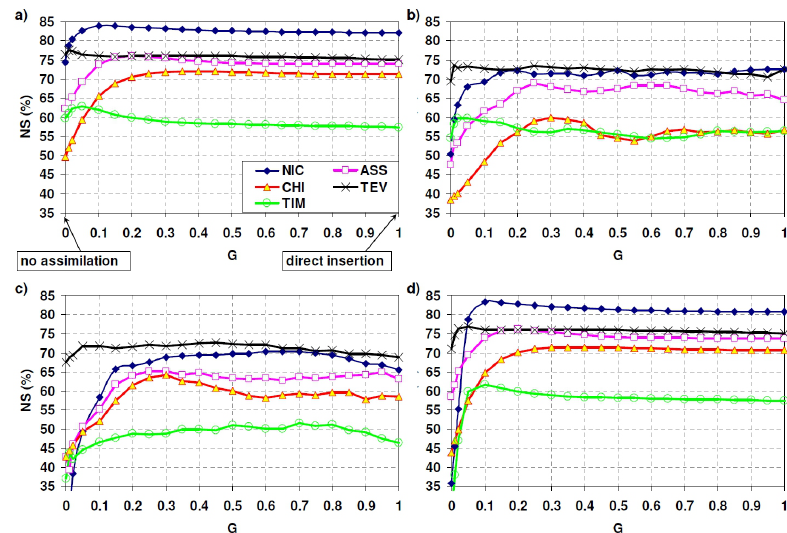
Fig. 3. – Nash-Sutcliffe efficiency index, NS, versus the Gain parameter, G, for all the investigated catchments: (a) observed data, (b) unbiased rainfall error, (c) MISDc parameters error, and (d) initial conditions